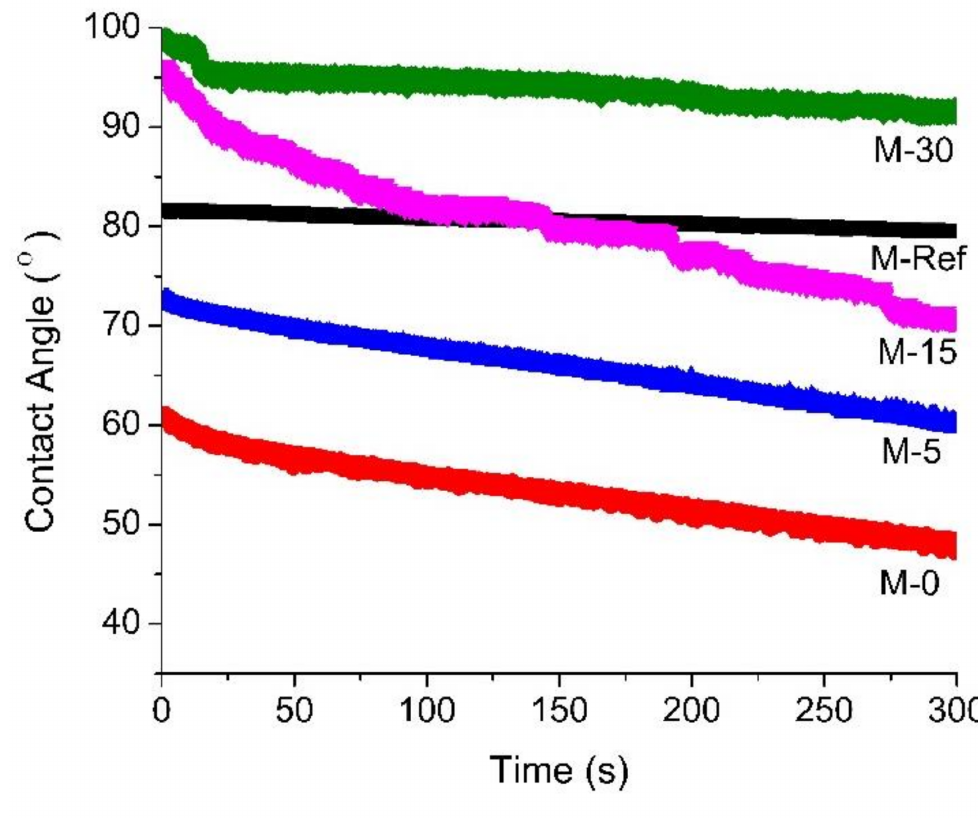
Figure 5. Dynamic contact angle of the developed